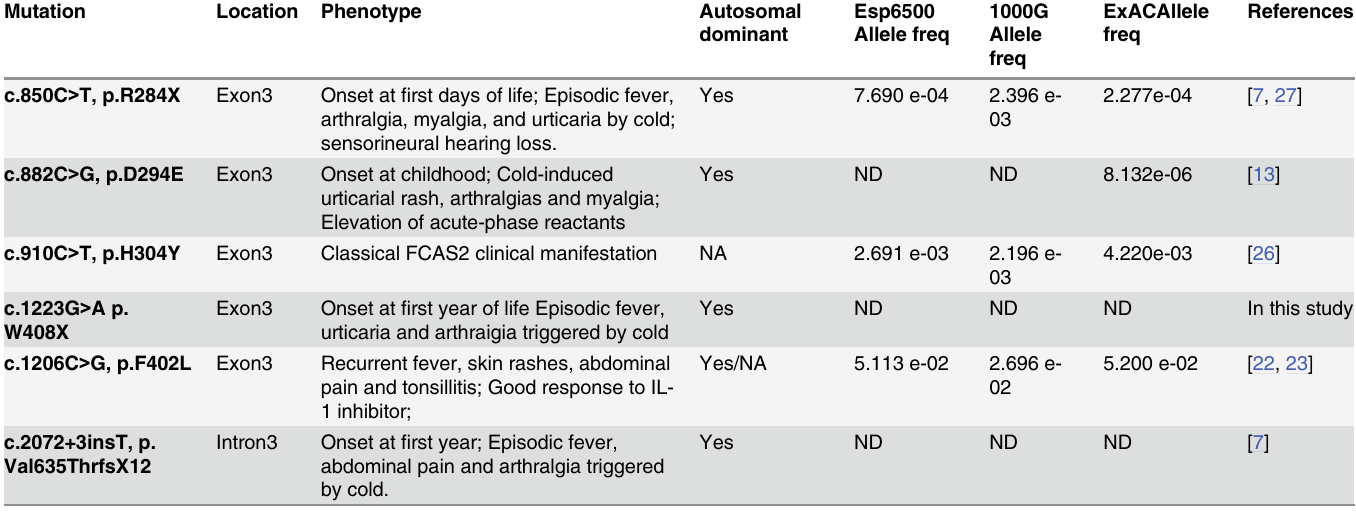
Table 3. NLRP12 Gene Mutations and Diseases. ND, Not detectable; NA, No answer.